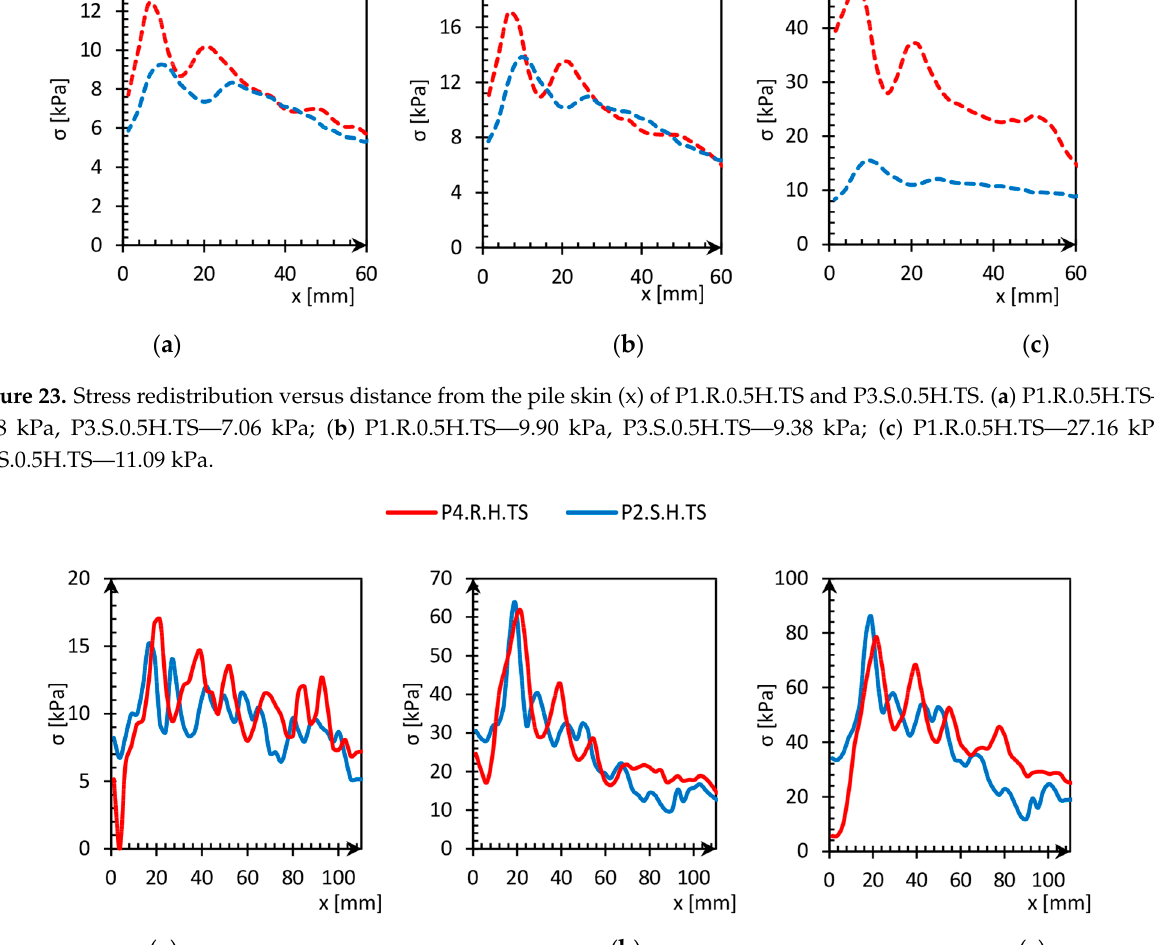
Figure 24. Stress redistribution versus distance from the pile skin (x) of P2.R.H.TS and P4.S.H.TS. ( a ) P2.R.H.TS—10.27 kPa,